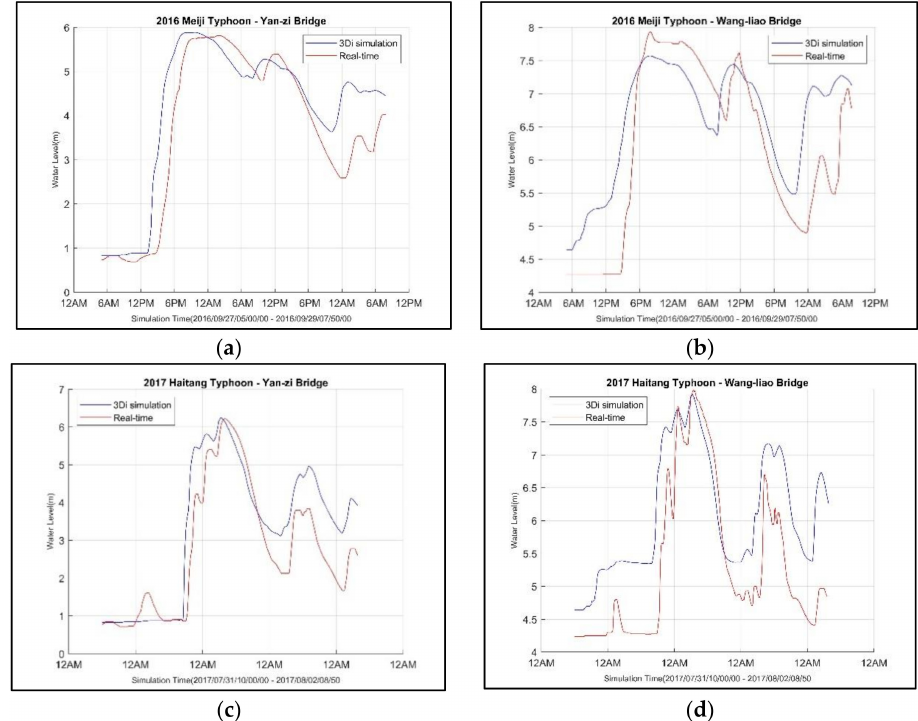
Figure 3. Comparison between flood simulation (blue color) and observation (red color) from the water level station at the ( a ) Yanzi Bridge during Typhoon Megi, ( b ) the Wangliao Bridge during Typhoon Megi, ( c ) the Yanzi Bridge during Typhoon Haitan, and ( d ) the Wangliao Bridge during Typhoon Haitang (unit: m).